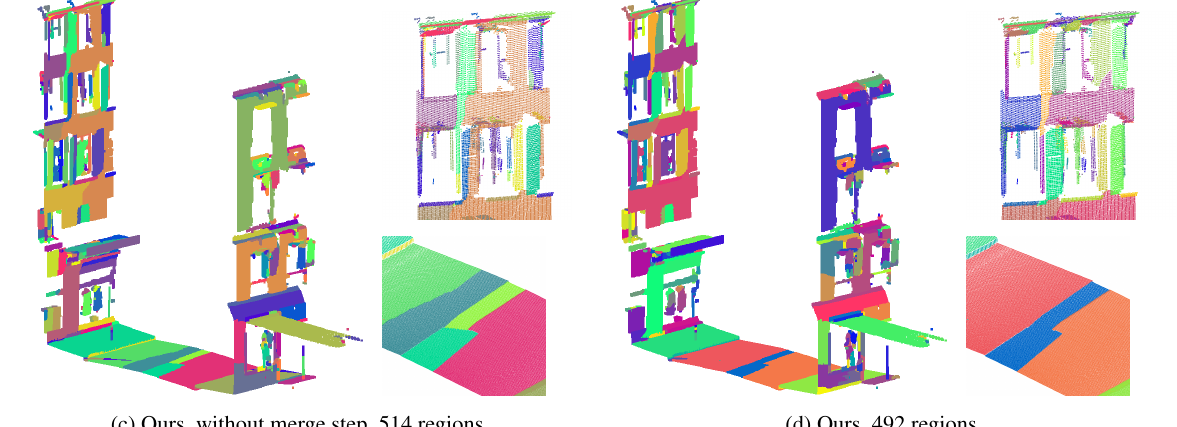
Figure 3. Comparison of the error between our method and the region-growing baseline on the urban dataset.